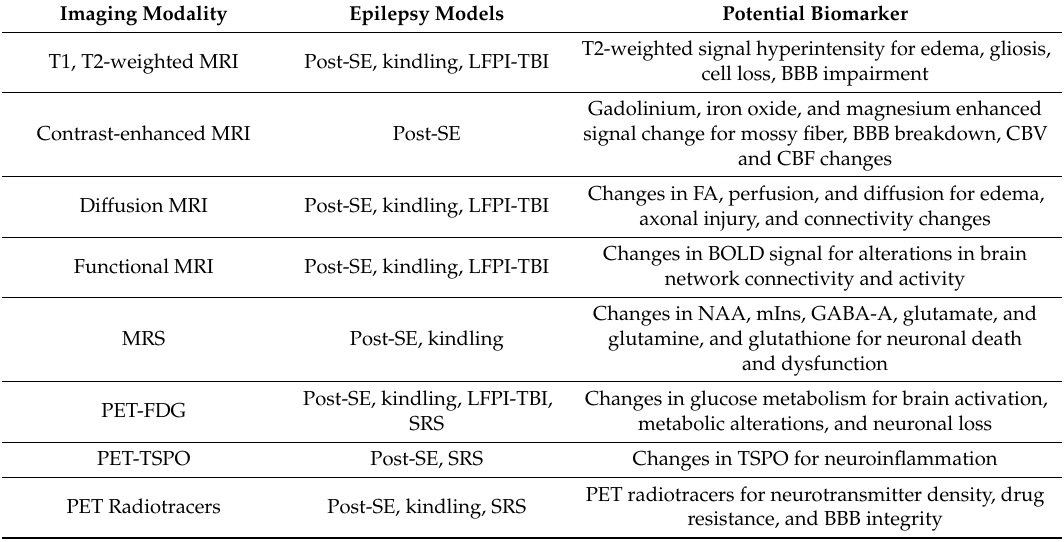
Table 1. Overview of in vivo imaging biomarkers for